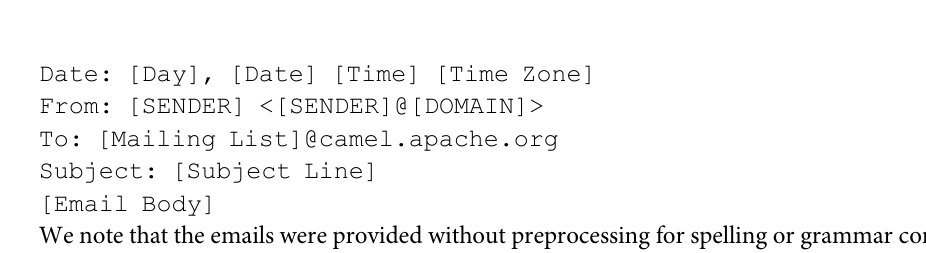
Fig 1. Time dependence of completed JIRA issues. 95% cumulative percentage of completed JIRA issues based on the time difference between creation and resolution of the issue. A mean time difference of 70 days, and a median of 1.3 days was observed.